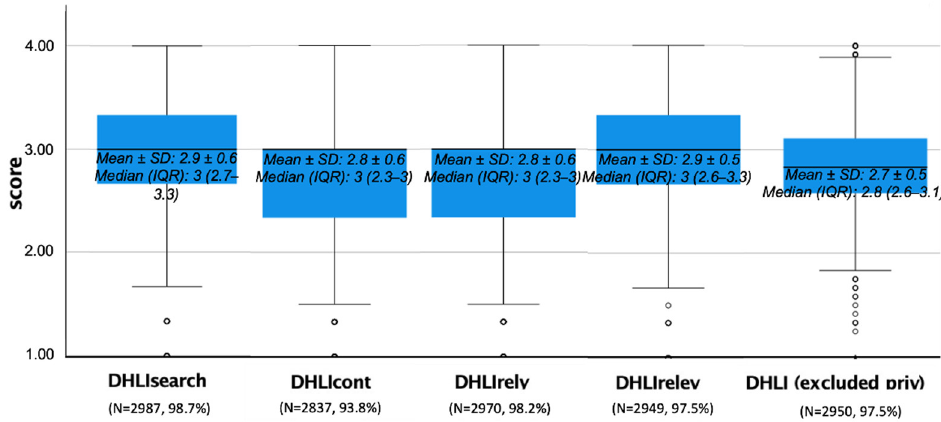
Figure 2. Descriptive analysis of the subscales and scale scores: box plots.